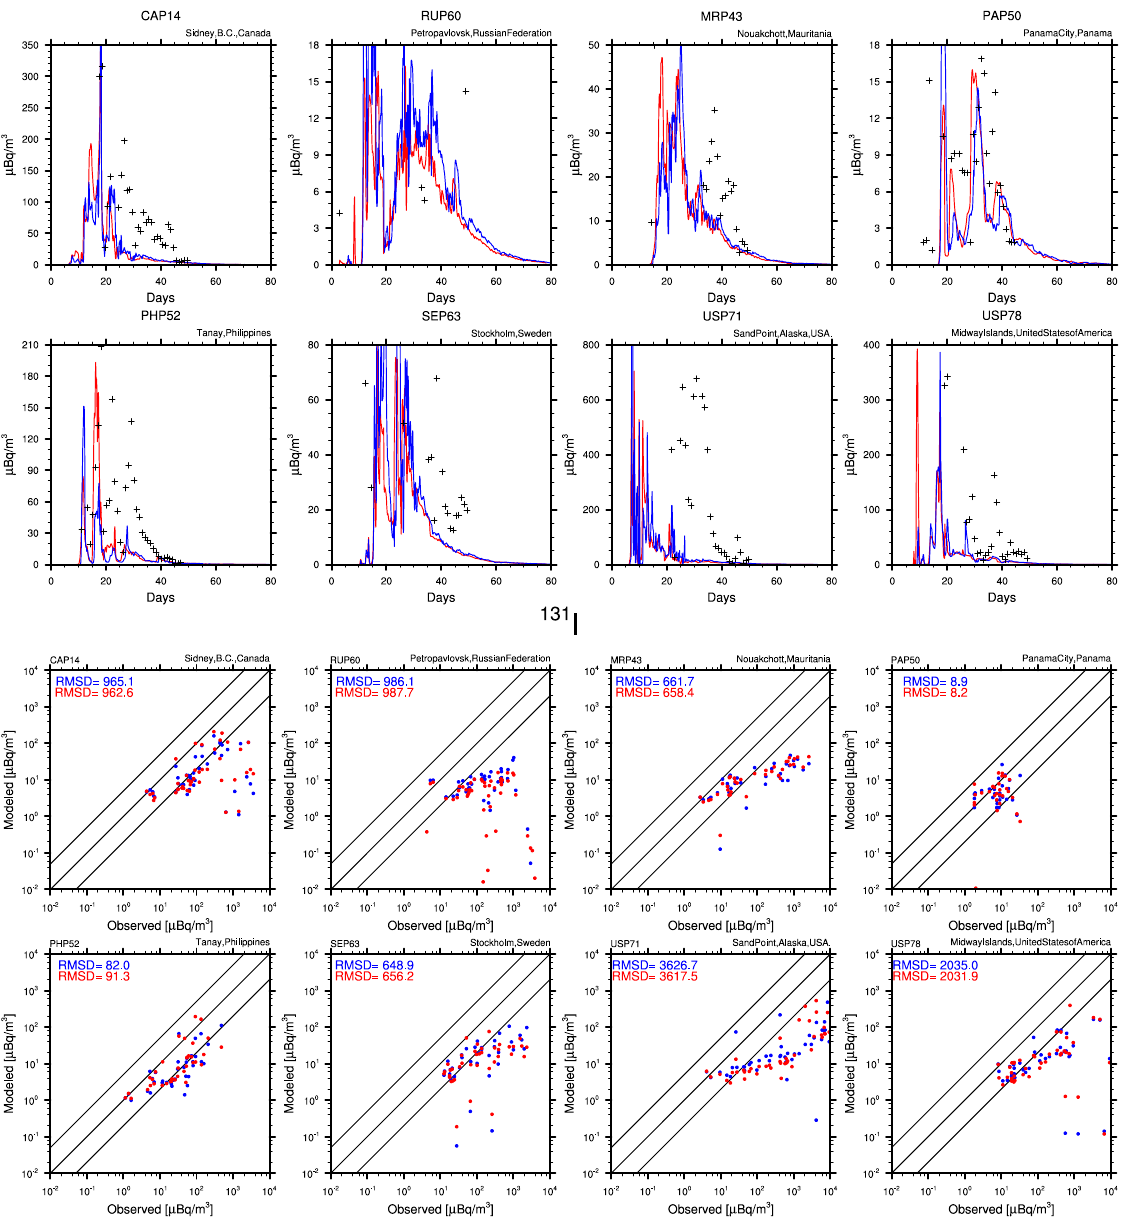
Fig. 5. Top: Observed (black points) and modeled (solid lines) surface concentrations of 131 I at eight selected stations. The station locations are the same as in Fig. 4. Due to the limited collection efficiency of the filter sampling of 131 I, the observations represent about 20–50% of the ambient concentrations. T255 horizontal resolution is shown in blue and T106 in red. The time axis represents days after the accident. Bottom: Modeled versus observed surface concentrations of 131 I at the eight stations. The diagonal lines represent the 1:1 ratio and the factor of 5 over- and underestimates.